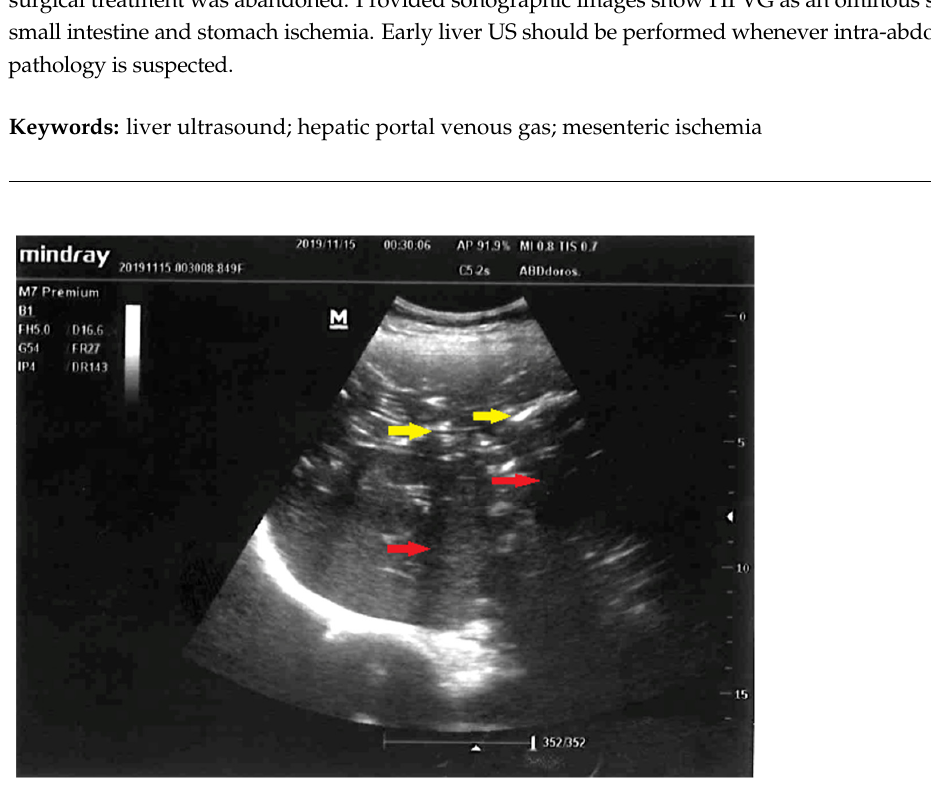
Figure 1. Early liver ultrasound (US) performed to find a source of sepsis in a 52-year-old female suspected to have developed intraabdominal sepsis. Visualized here are: normal-sized liver, punctuated